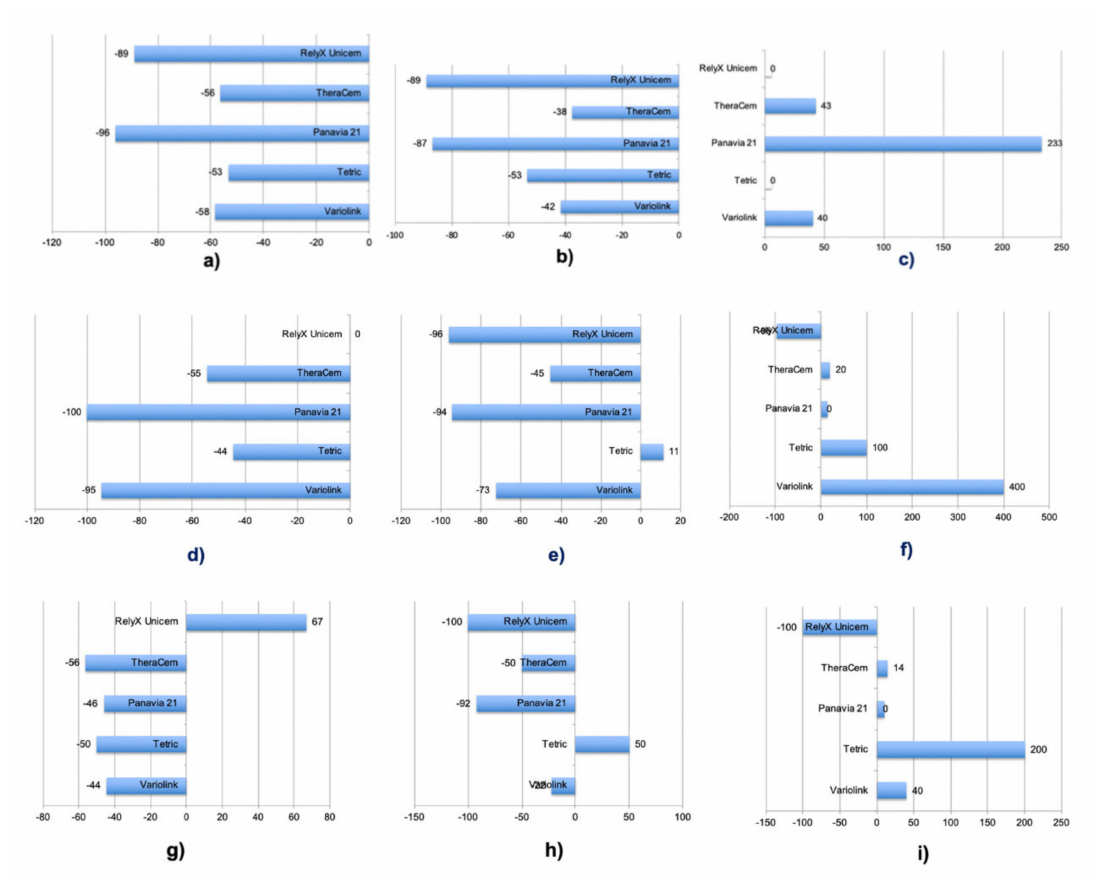
Figure 4. ( a – i ) In mould incremental build up (Protocol 1): ( a ) ∆ dry—thermocycling, ( b ) ∆ dry— 6 months of water storage, ( c ) ∆ thermocycling—6 months of water storage. ( d – f ) In mould incremental build up with subsequent mould removal (Protocol 2): ( d ) ∆ dry—thermocycling, ( e ) ∆ dry—6 months of water storage, ( f ) ∆ thermocycling—6 months of water storage. ( g – i ) In mould non-incremental bulk build up: ( g ) ∆ dry—thermocycling, ( h ) ∆ dry—6 months of water storage, ( i ) ∆ thermocycling—6 months of water